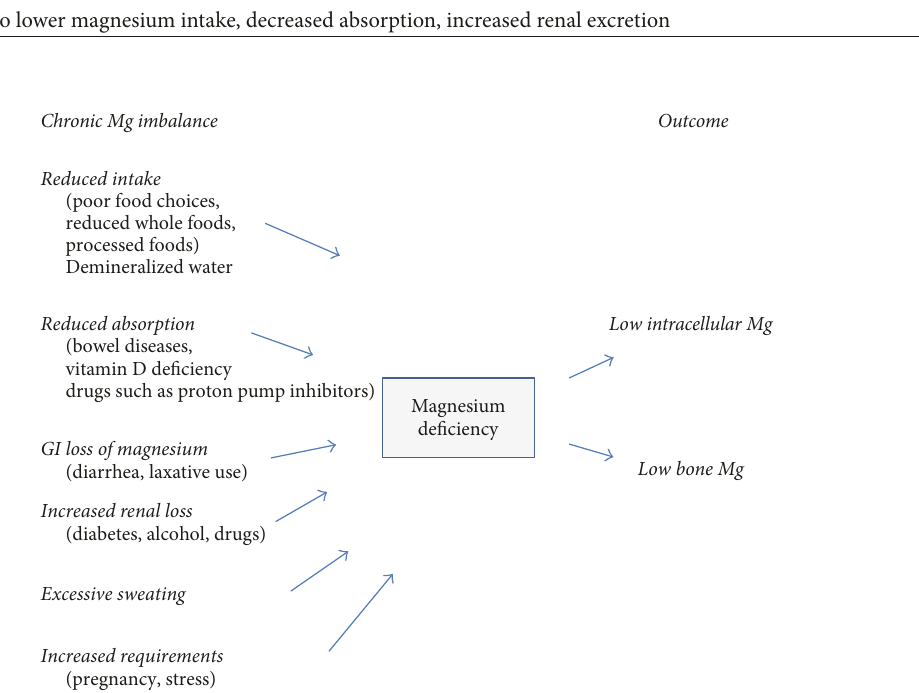
Figure 1: Etiology of chronic magnesium deficiency